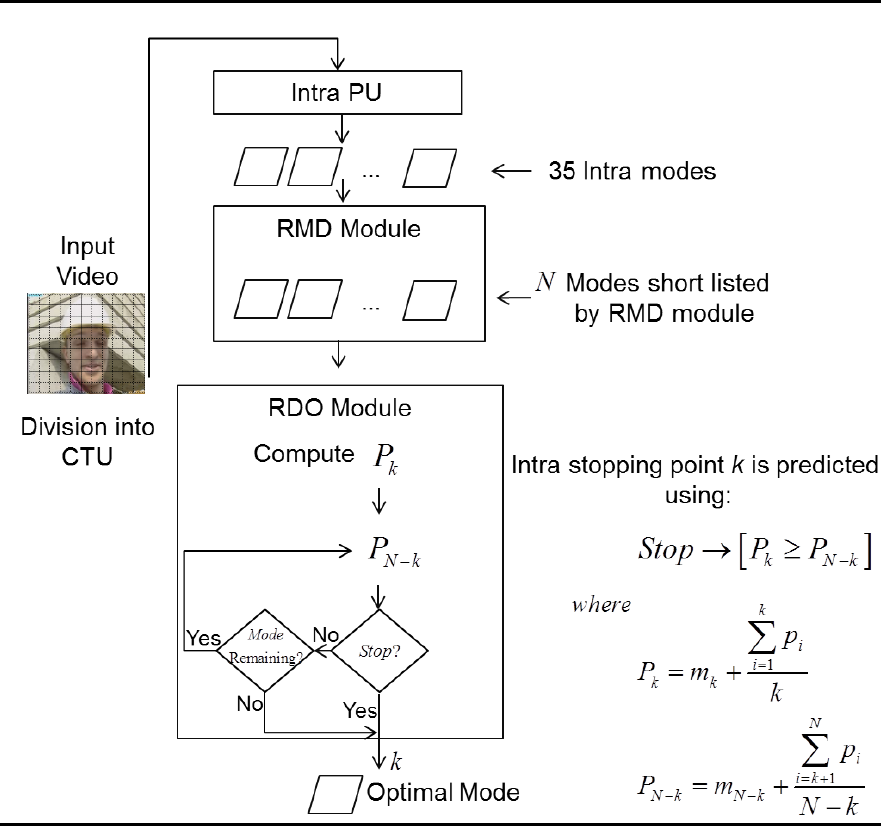
Figure 7. Flowchart of the proposed